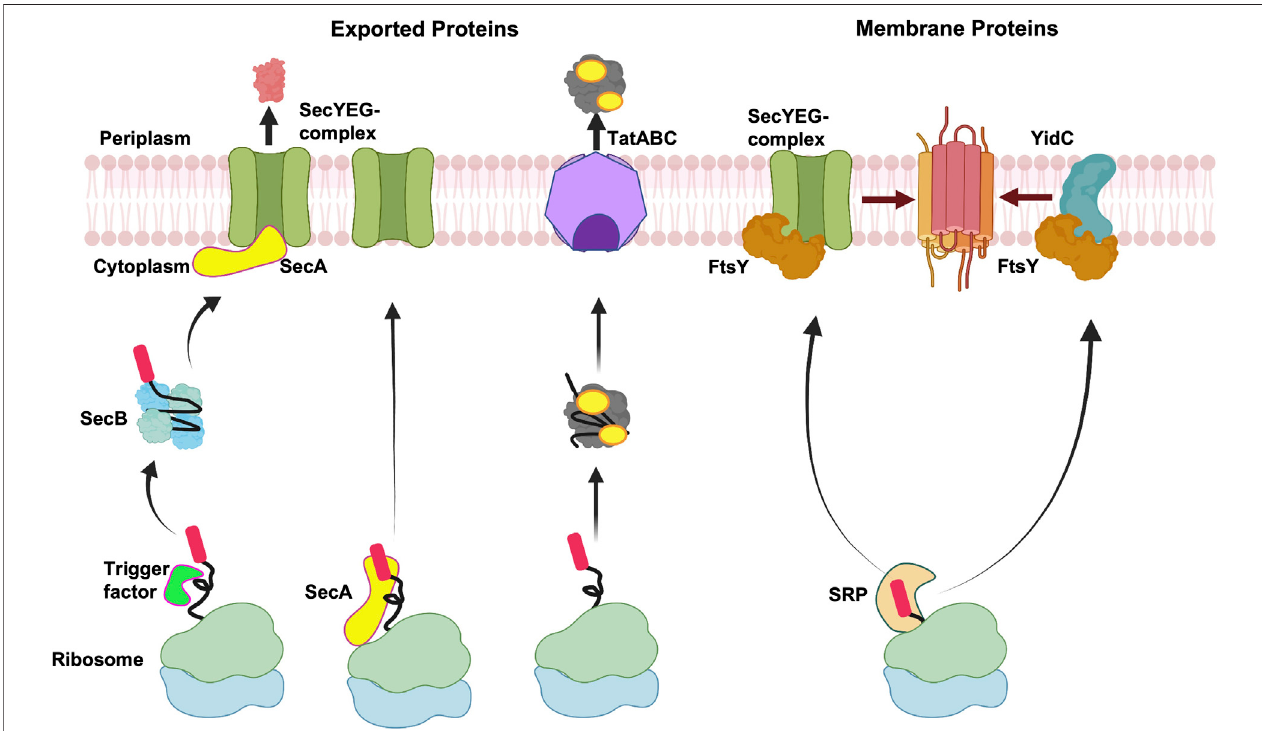
FIGURE 2 | Membrane targeting pathways. Overview of targeting of exported proteins and membrane proteins. After exported proteins are released from the ribosome, Sec-dependent proteins can be stabilized by the molecular chaperone SecB in an unfolded state and then targeted to SecA at the membrane, followed by translocation by theSecYEG complex. Alternatively,SecA can interact with theribosomebound nascentchain and target the exported protein tothe SecYEG complex. In case of Tat complex, the proteins fold in the cytoplasm before being exported by the Tat complex. In the event of co-translational targeting, the nascent membraneproteinsformacomplexwithSRP,whichtargetproteinstoFtsY(SRPreceptor) formembraneinsertioneitherbytheSecYEGcomplexortheYidCinsertase. Created with BioRender.com.